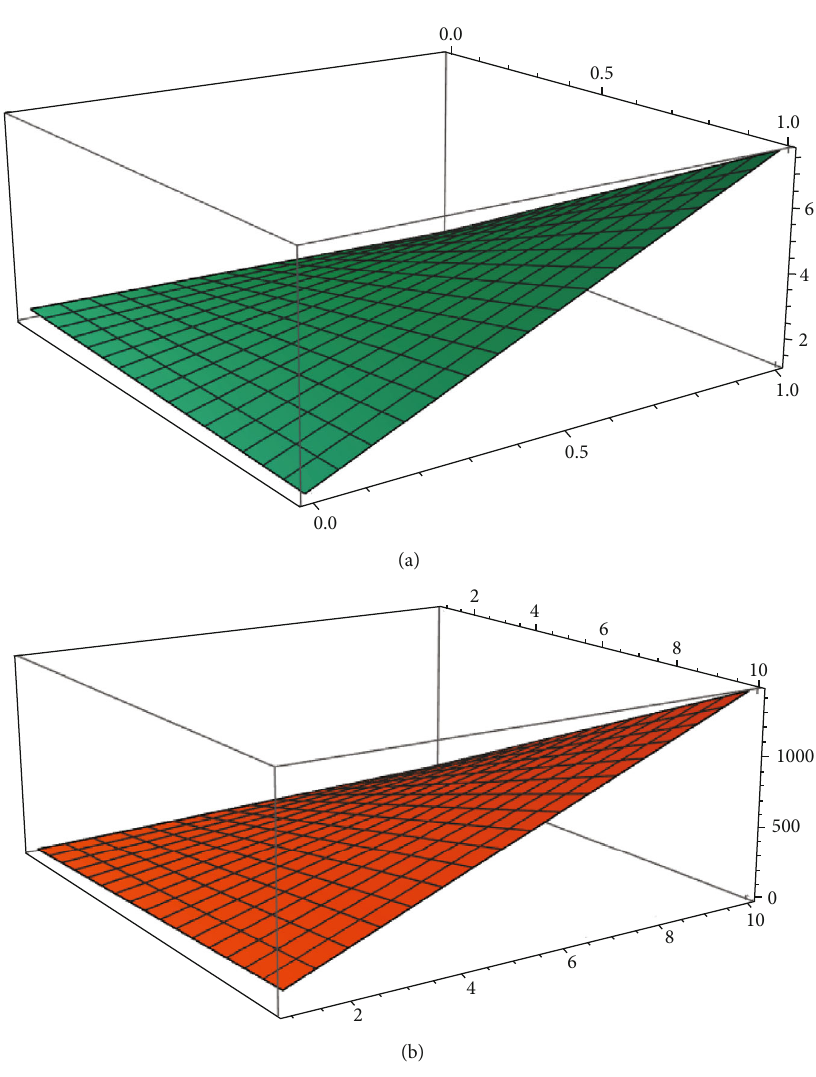
Figure 6: (a) Ve-deg-based ABC-index and (b) ve-degree-based